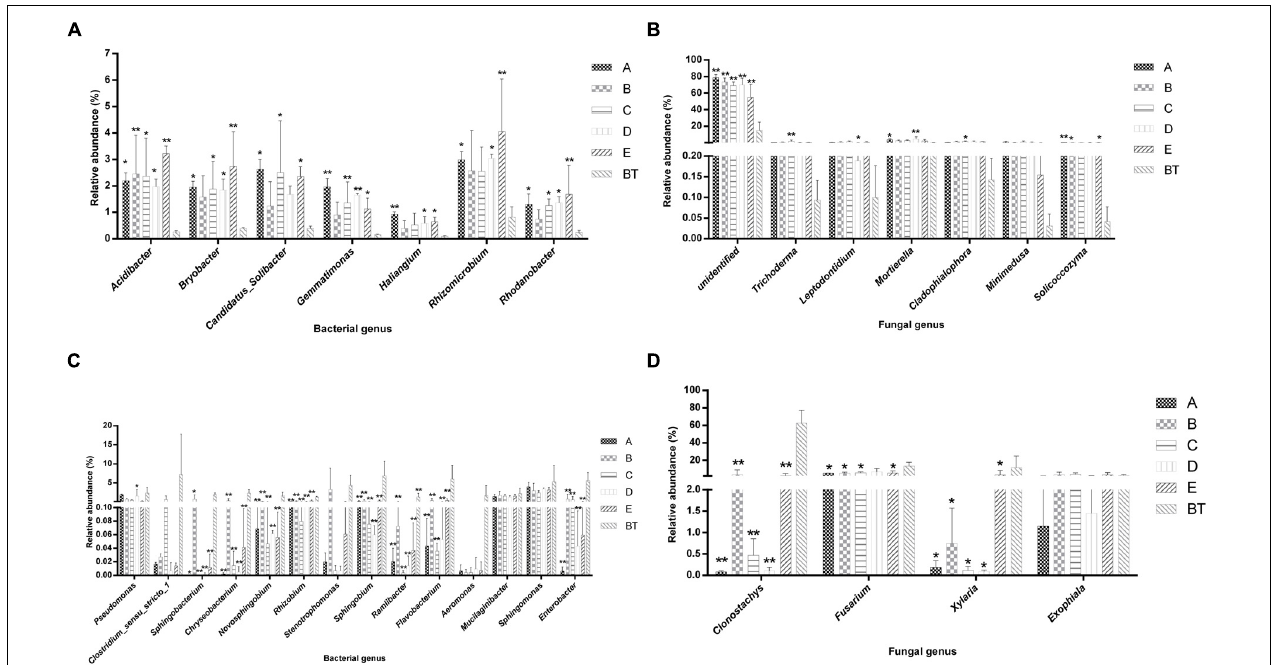
FIGURE 2 | Column chart analysis of dominant bacterial and fungal genera in rhizospheric soil of plants. (A) Increase of relative abundance of potential beneficial bacterial genera. (B) Increase of relative abundance of potential beneficial fungal genera. (C) Decrease of relative abundance of potential harmful bacterial genera. (D) Decrease of relative abundance of potential harmful fungal